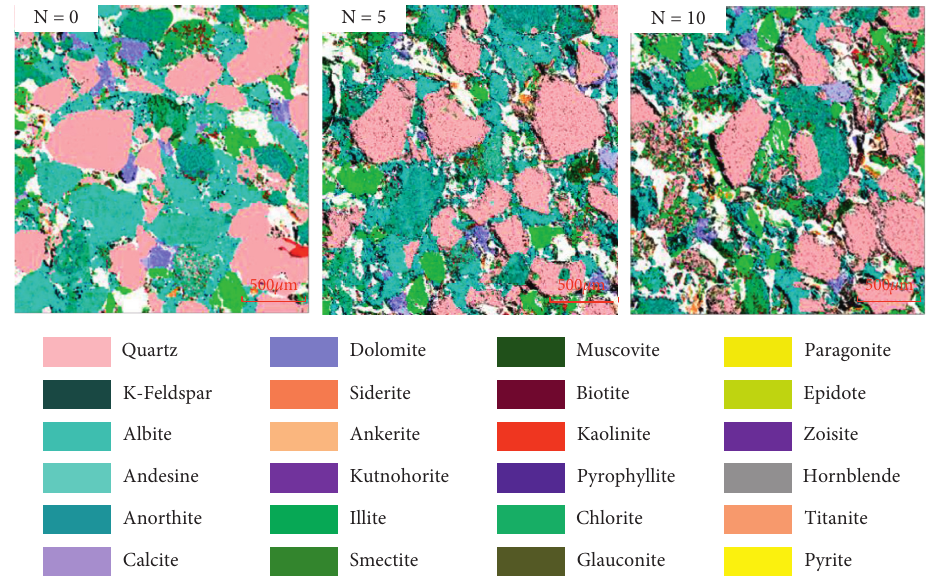
Figure 2: QEMSCAN images of weakly cemented sandstone under different numbers of dry-wet